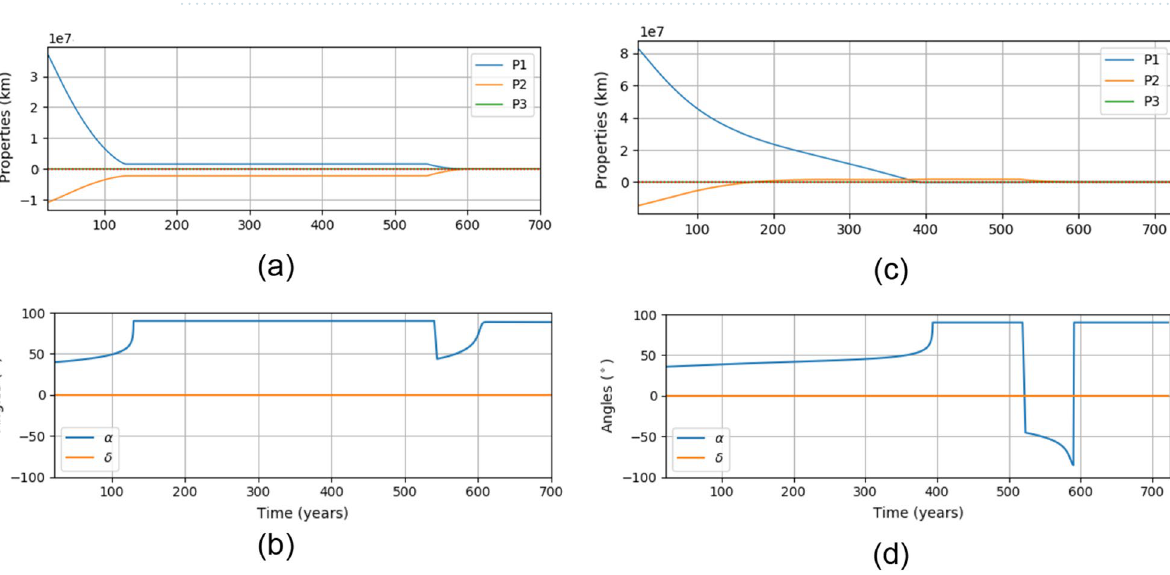
Figure 6. Guidance properties and orientation angles α and δ . ( a ) Properties for transfer with tof of 700 days. ( b ) Angles for transfer with tof of 700 days. ( c ) Properties for transfer with tof of 725 days. ( d ) Angles for transfer with tof of 725